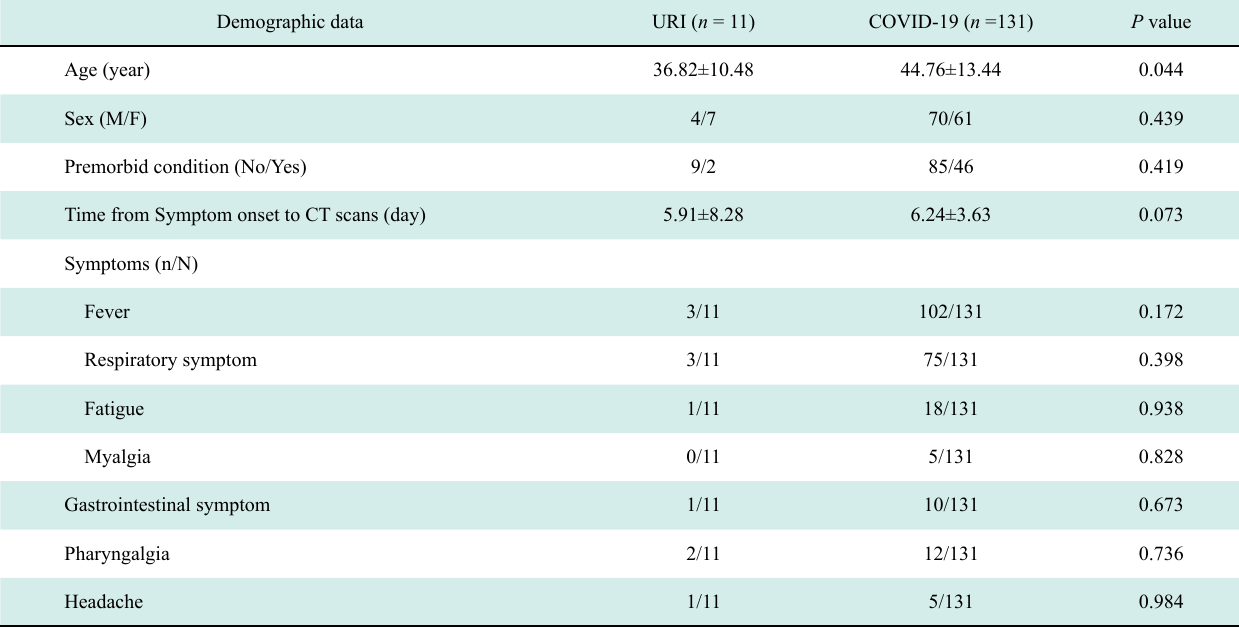
Table 1 Baseline characteristics of patients with URI and COVID-19 separately Demographic data